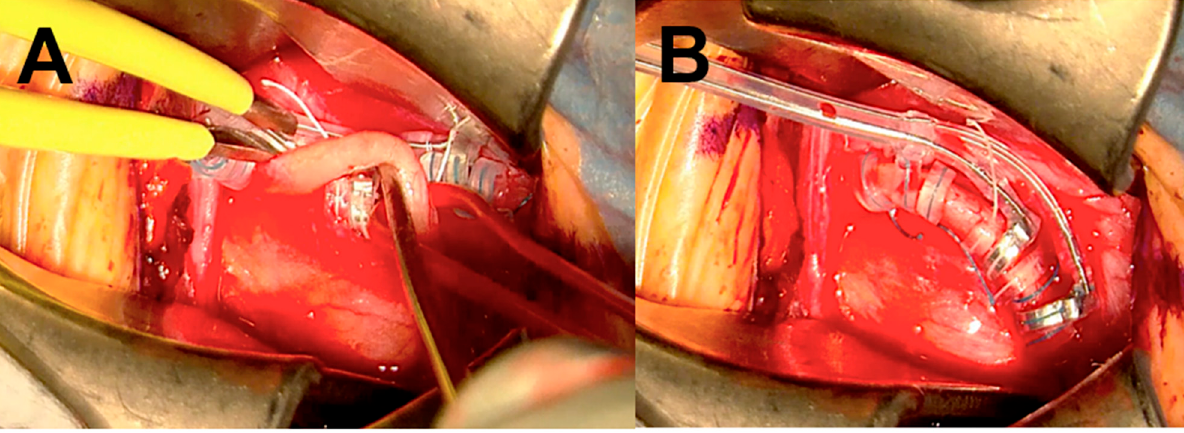
Figure 7. A screenshot of the intraoperative recordings of vagus nerve stimulation in a patient suffering from therapy- resistant depression. The vagus nerve is illustrated in ( A ) during electrode placement. ( B ) represents the final view after electrode placement.